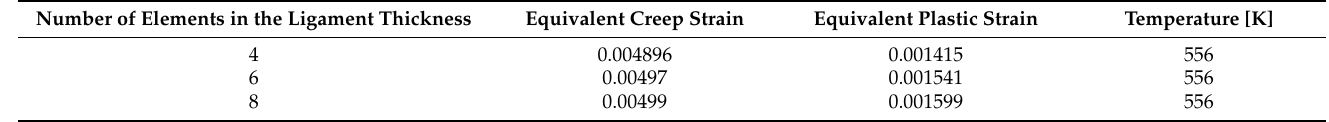
Table 9. Plastic strains, creep strains, and temperature values at the end of the hot